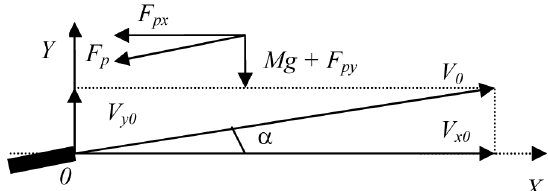
Fig. 1. Forces influencing a bullet moving through the air, components of its velocity. Aiming line (straight line running from the shooter’s eye through the sight towards the aiming point) shown in dots and coinciding with the x axis, a – aiming angle, i.e. , angle between the elevation (direction of the barrel) and the aiming